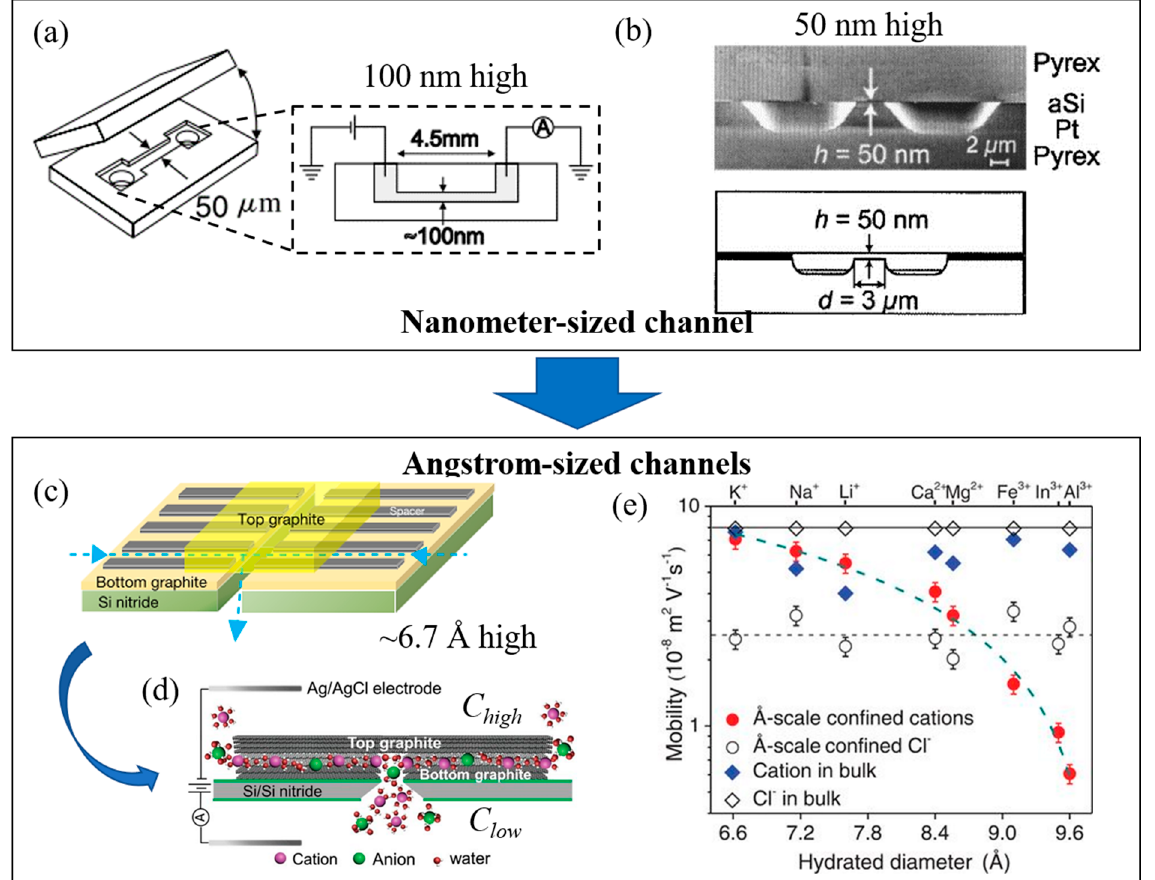
Figure 7. Schematic illustration of the fabrication of slits in nanometer-sized channel (top image) and angstrom-sized channels (bottom image). ( a ) Nanochannel assembly with cross-sectional side view (100 nm high). ( b ) Cross section of nanochannels (50 nm high) as defined by the thickness of the silicon layer and the nanochannel length ( d = 3 μ m). ( c ) Schematic of graphene capillary devices showing the composition of each device. The arrow indicates the flow direction of electrolyte. ( d ) Schematic of ion transport under nanocapillary channels (channel height = ~6.6–6.7 Å) driven by the drift-diffusion techniques. ( d ) The individual ion mobility in Å-confined channels (using bilayers of graphene as spacers between the materials) as a function hydrated diameter, which were compared to their ion mobilities in bulk solutions. Reprinted with permission from ( a ) ref. [64] Copyright (2004) American Physical Society (United States), ( b ) ref. [63] Cop- yright (2005) American Institute of Physics (United States), ( c ) ref. [68] Copyright (2016) Macmillan Publishers Ltd., and ( d , e ) ref. [69] Copyright (2017) The American Association for the Advancement of Science.